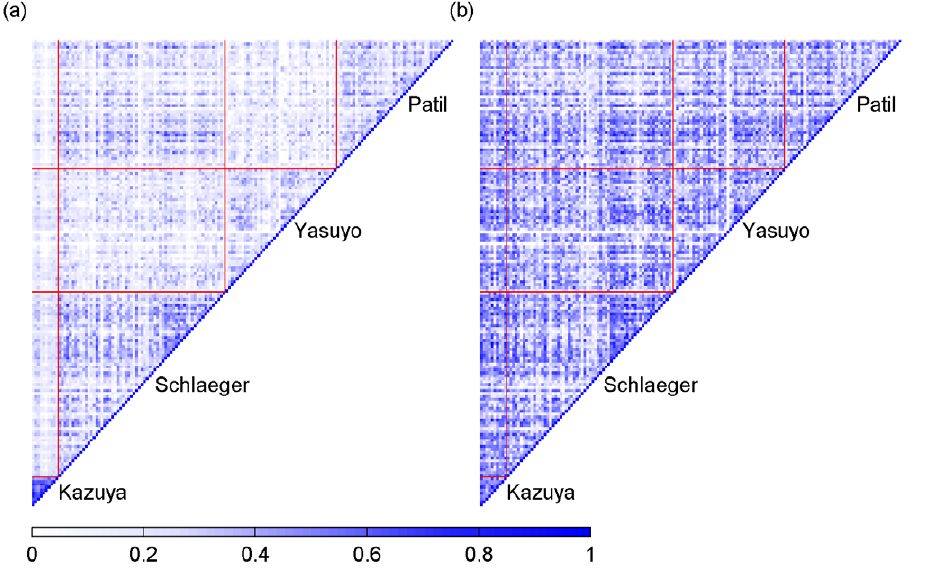
Figure 1. Comparison of correlations among log2-transformed ratios of 159 samples from four independent datasets before (a) and after preprocessing (b). In triangle (a) and (b), color points dotted in rectangles represent PCC values of log2-transformed ratio between any two samples from different datasets, while color points dotted in small triangles represent those from same dataset. The brightness of color blue is directly proportional to the value (0 – 1) of Pearson correlation coefficient.